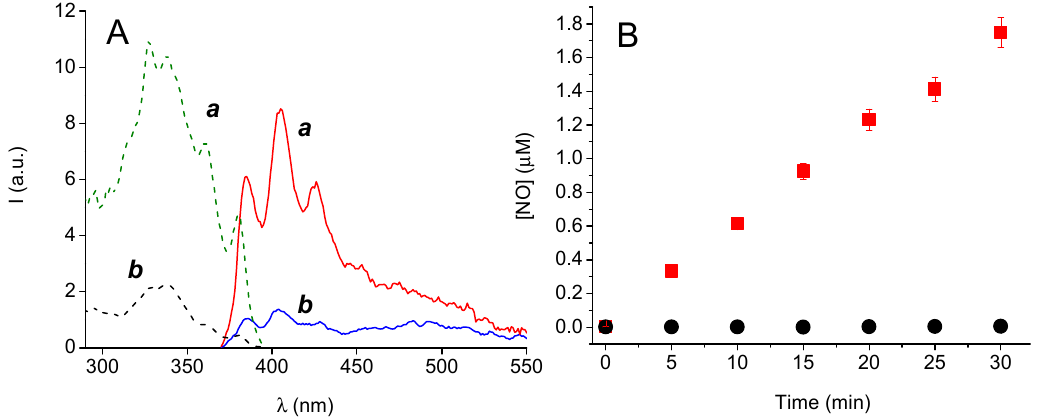
Figure 3 . ( A ) Representative fluorescence emission (solid, λ exc = 360 nm) and excitation (dotted, λ em = 405 nm) spectra obtained after fluorimetric assay of CL loaded with 1 , immersed in 3 mL of artificial tears solution, and exposed to daylight ( a ) or kept in the dark ( b ). ( B ) NO concentration, determined